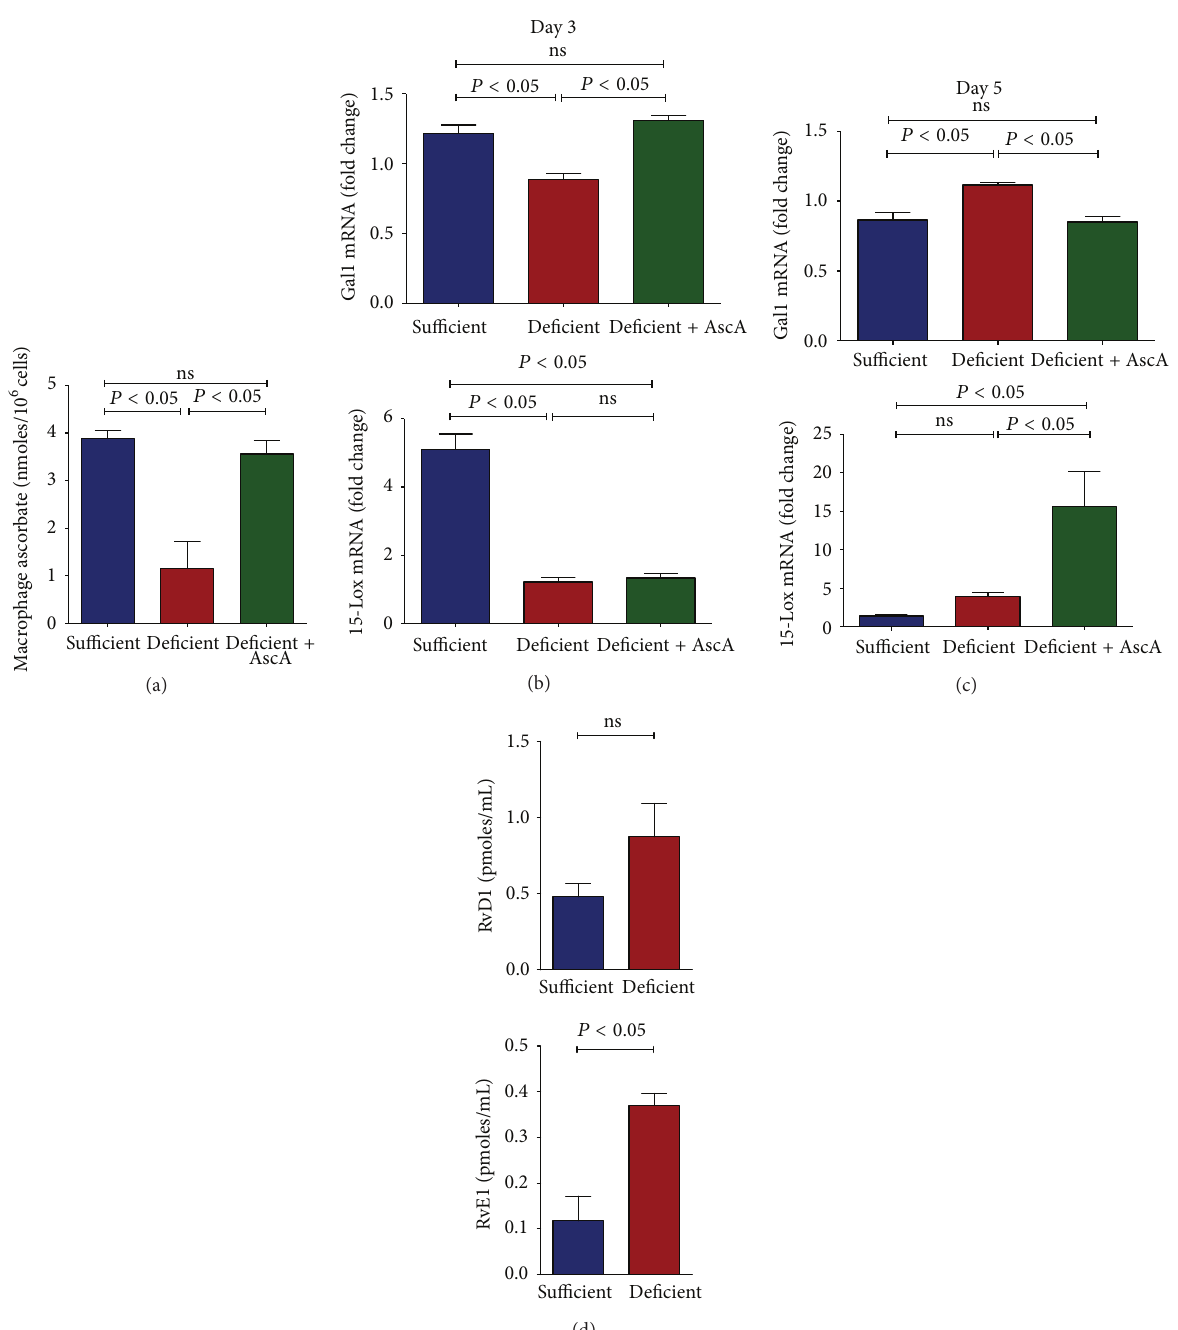
Figure 4: Vitamin C regulates macrophage function during the resolution of inflammation. (a) Macrophages were isolated on day 3 following TG-mediated peritonitis from VitC sufficient or deficient mice as well as in deficient mice treated daily with i.p. AscA for 3 days and intracellular concentrations of VitC measured ( 𝑁 = 3–10 mice/group, ns = not significant). (b) Real time QPCR for Gal1 and 15-Lox